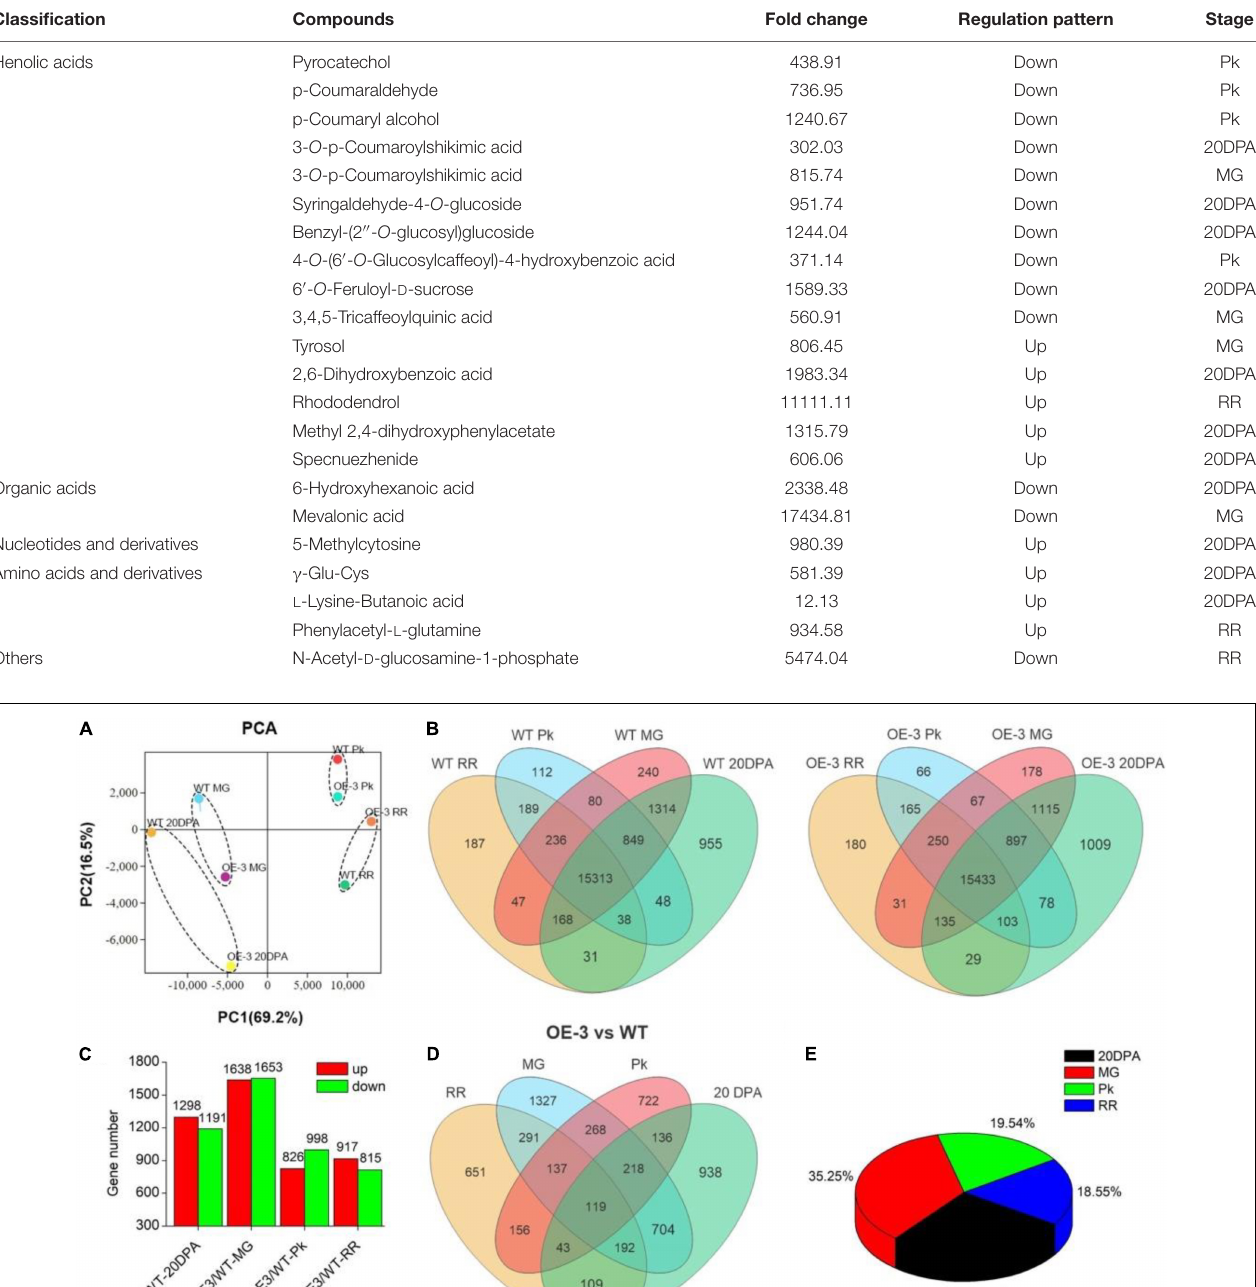
TABLE 1 | Classification, fold change, regulation pattern, and development stages of compounds with more than 10-fold change.